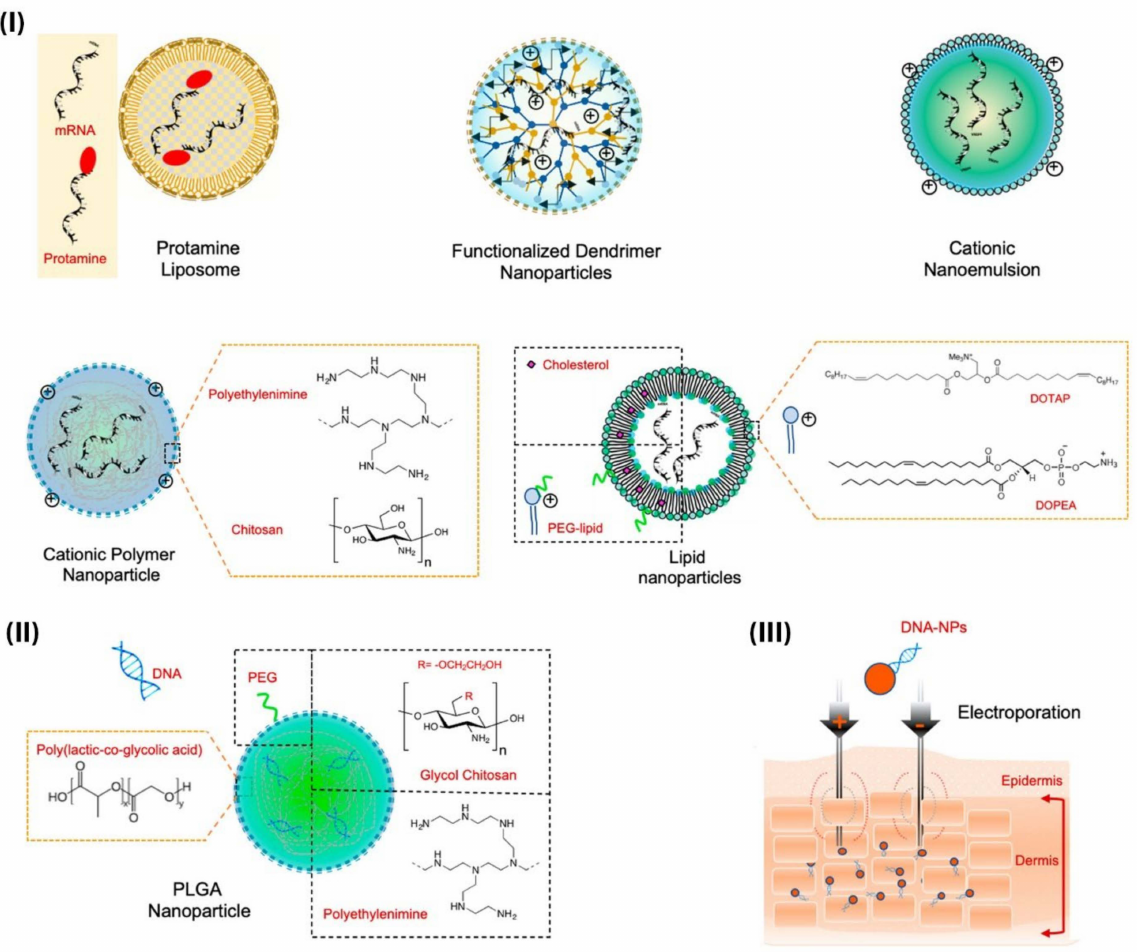
Figure 7. Nano-delivery methods for mRNA and DNA vaccines; ( I ) common carriers for delivery mRNAs, ( II ) PEG based-nanocarriers for DNA delivery, ( III ) electroporation technology for DNA delivery. Reproduced with permission from [112]. Copyright American Chemical Society,